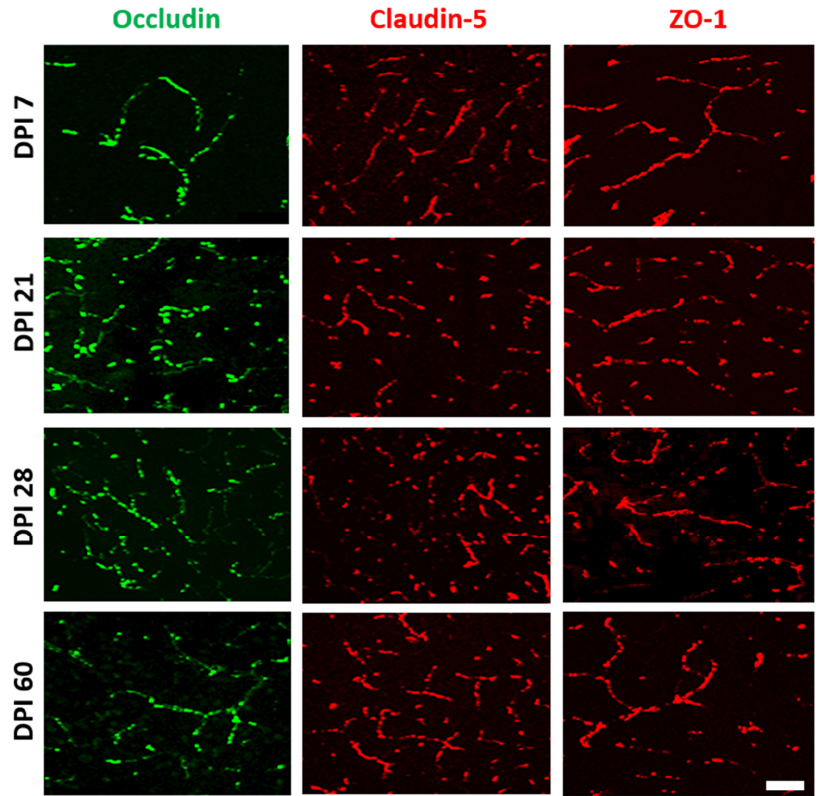
Figure 8. Temporal course of fluorescence immunolabeling for cell junctions in brain tissue of mice infected with M. tuberculosis N15 (LAM 3). Scale bar = 20 μ m is common for all micrographs.